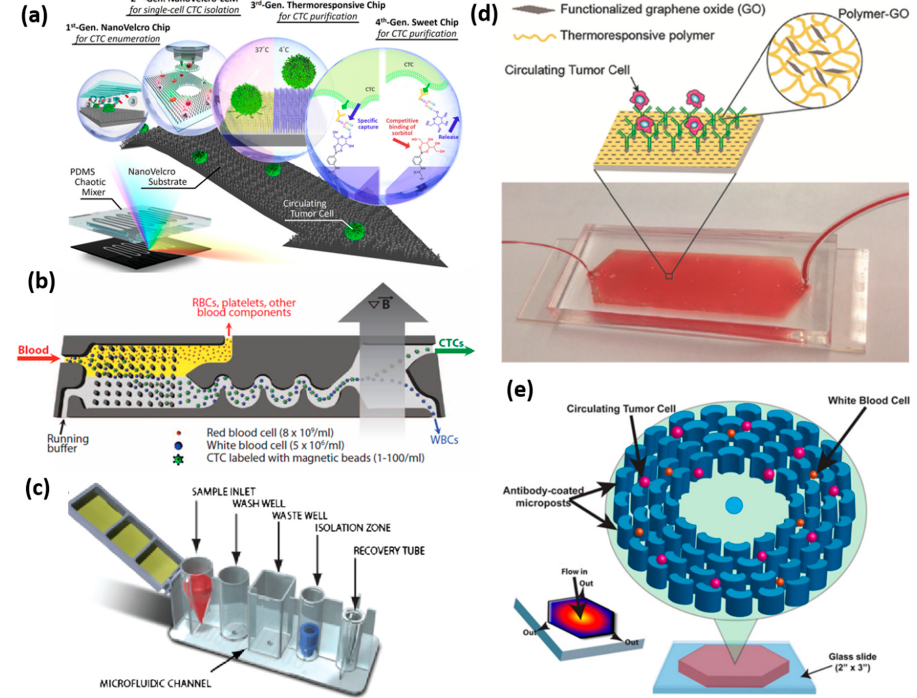
Figure 2. Affinity CTC selection method. ( a ) The graphic illustration of the NanoVelcro CTC chip